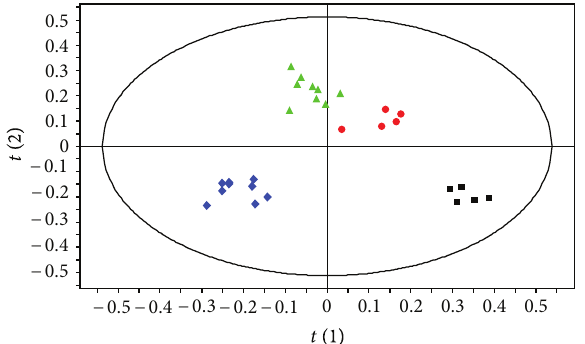
F 3: PLS-DA score plot based on the marrow samples from nonexposed male (green